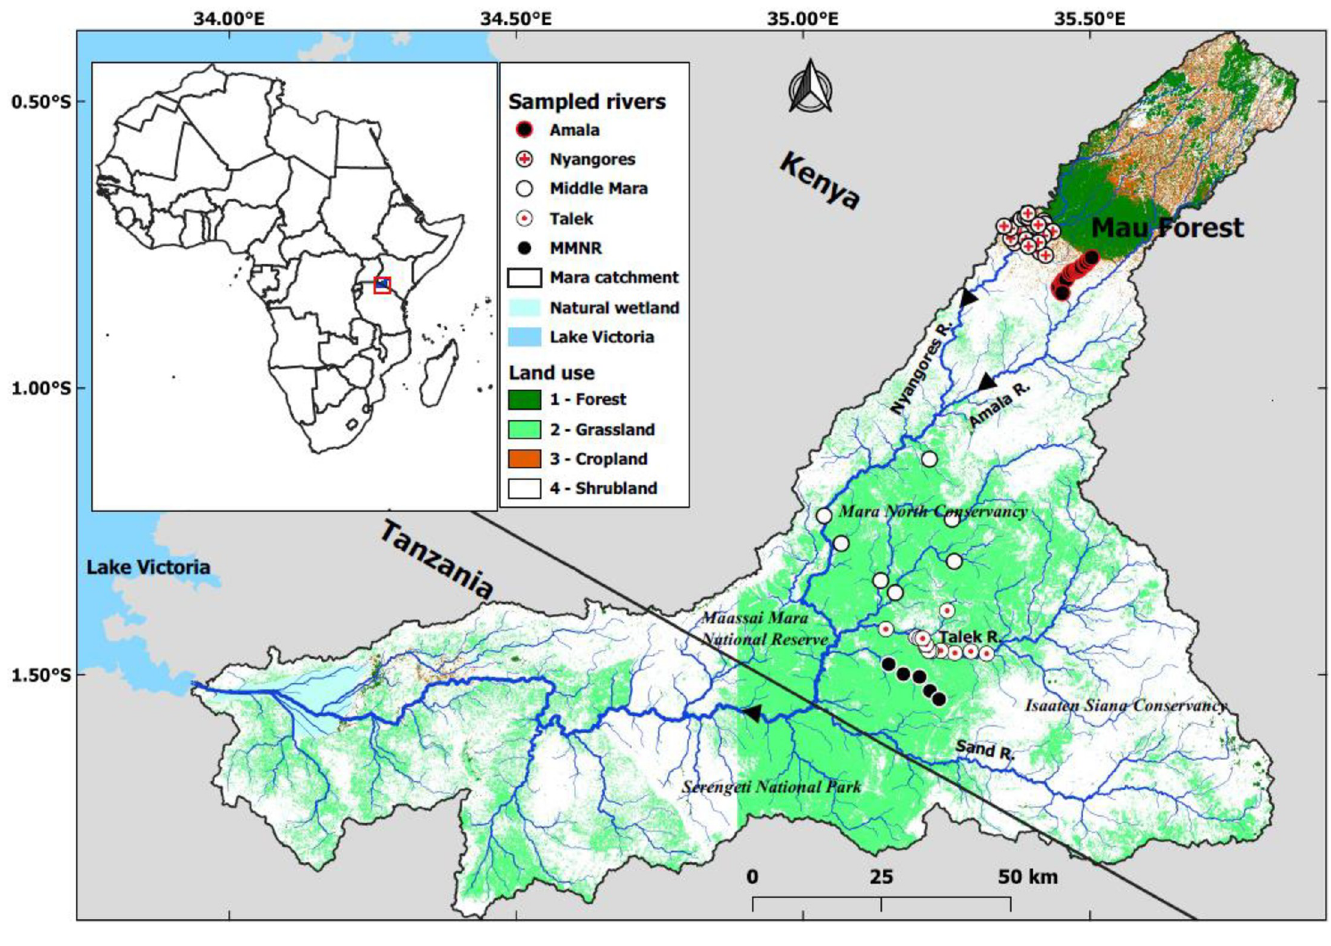
Fig 1. Map of the study area showing the location of the livestock study sites in the four regions in the Mara River basin, Kenya. The MMNR sites are within the Maasai Mara National